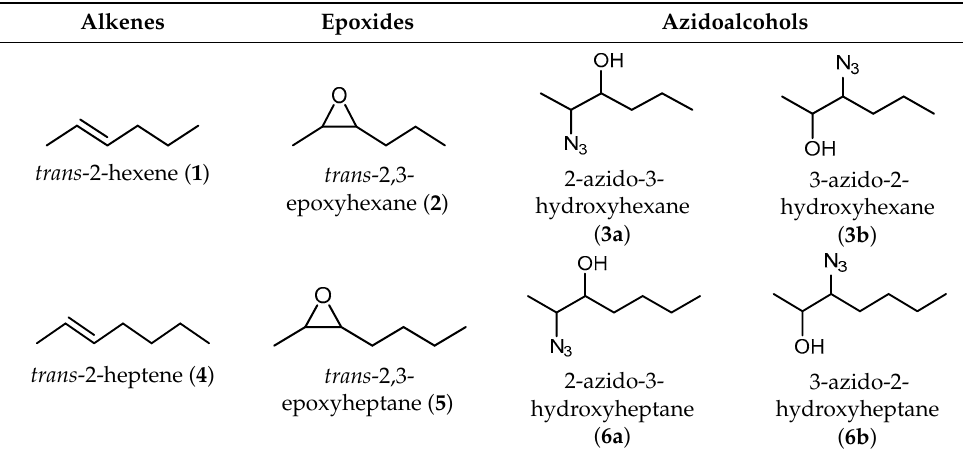
Table 3. List of compounds used in this work.